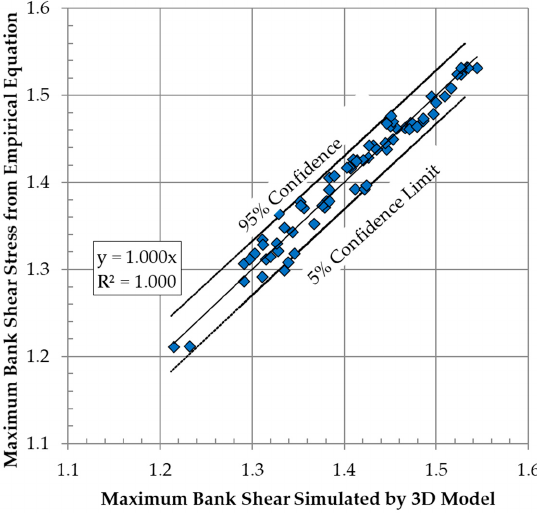
Figure 50. Comparison of maximum dimensionless near-bank shear stresses (computed by Equation (23)) and simulated by the 3D model.